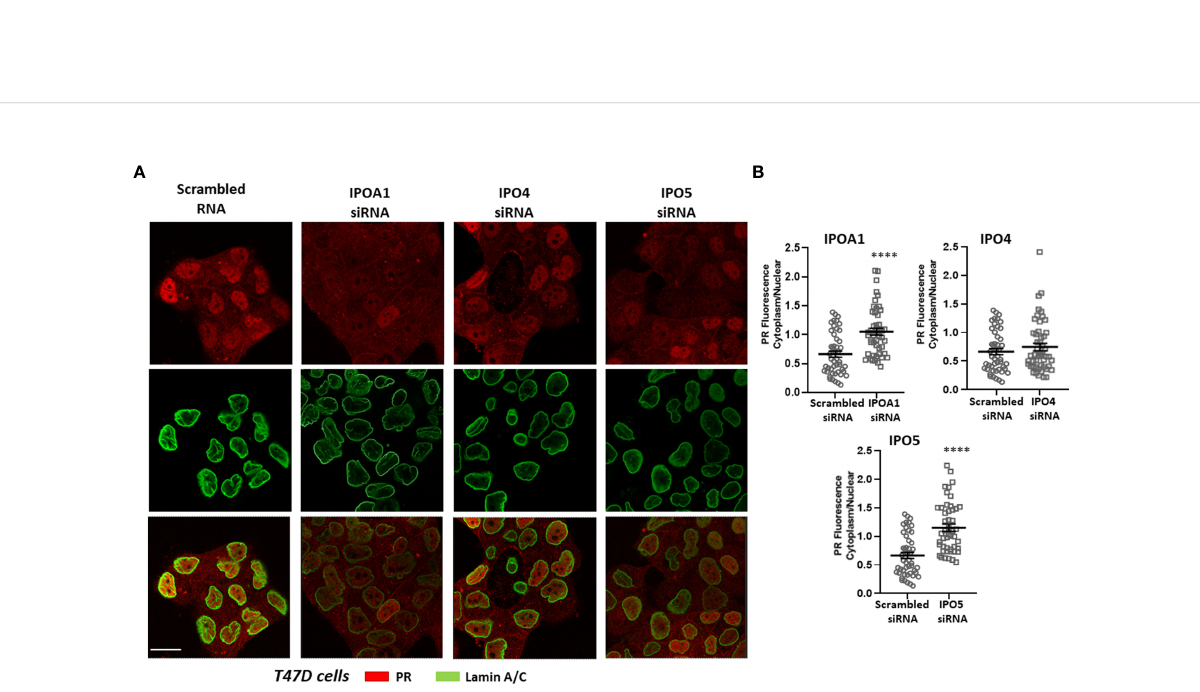
FIGURE 4 (A) Representative confocal pictures of T47D cells stained for progesterone receptor (PR) (red) and lamin A/C (green) (3 rd raw is their overlay). T47D cells were either transfected with a scrambled siRNA or a speci fi c siRNA for importin a (IPOA1), importin 4 (IPO4) or Importin 5 (IPO5) treated with ORG-2058 (10 -7 M) for 90 min to ensure nuclear localization. Magni fi cation x1260 (scale bar, 40 m m). (B) Intensity of fl uorescence in the cytoplasm and nucleus was quanti fi ed (see Material and Methods for details) in at least 50 cells from 3 independent experiments (n=3) and is given as the Cytoplasm/Nuclear fl uorescence ratio in each condition. **** denotes statistical signi fi cance P< 0.0001.